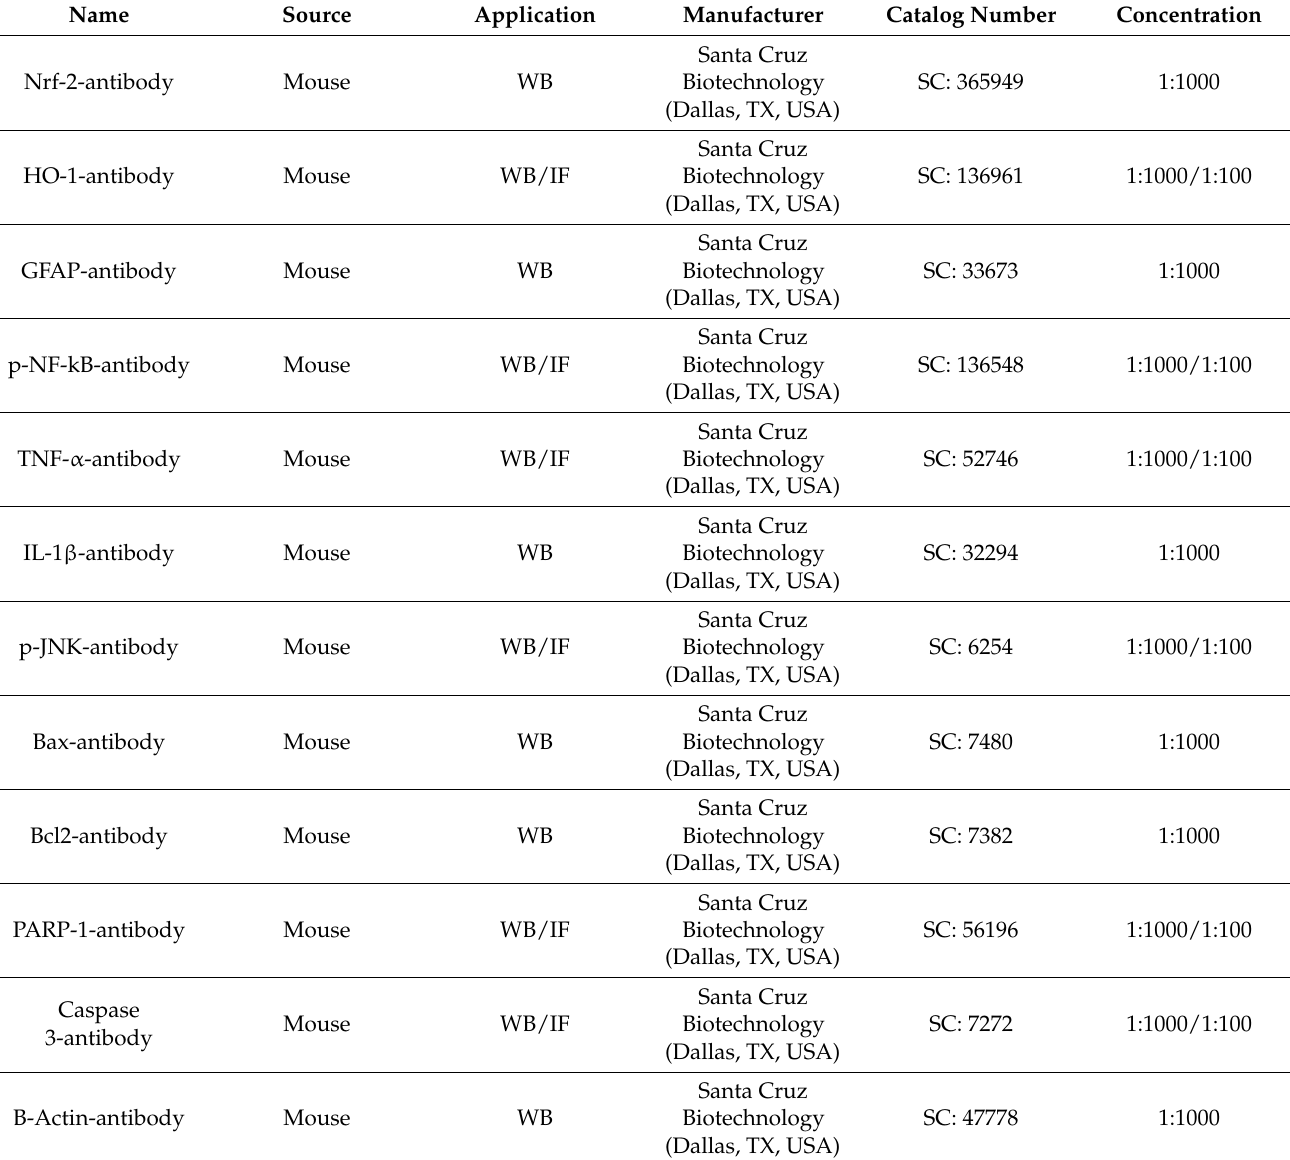
Table 1. List of antibodies used for Western Blot (WB) and immunofluorescence (IF)